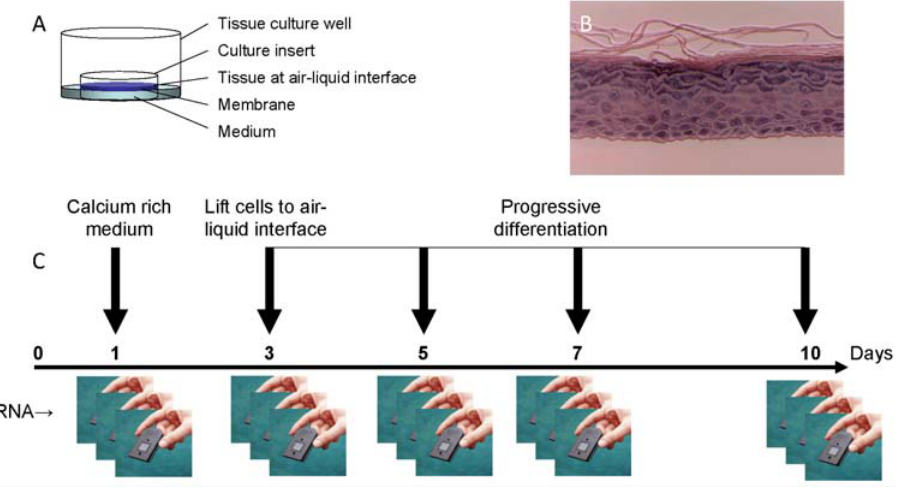
Figure 1. The EpiDerm TM model of keratinocyte differentiation. The figure shows a schematic of the experimental design including the culture arrangements (A). The fully differentiated model (B) (MatTek Corporation) contains organized basal, spinous, granular, and cornified layers analogous to those found in normal human skin. The course of the experiment (C) includes biological triplicates taken for microarray analyses at five points, starting before the addition of calcium to the culture